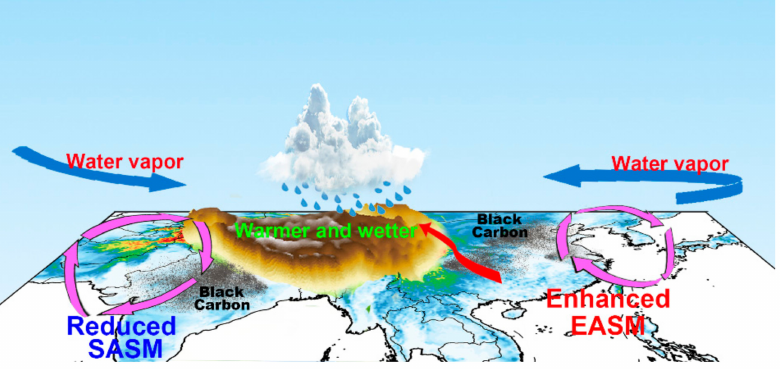
Figure 13. Mechanism of BC a ff ecting water vapor transport over the